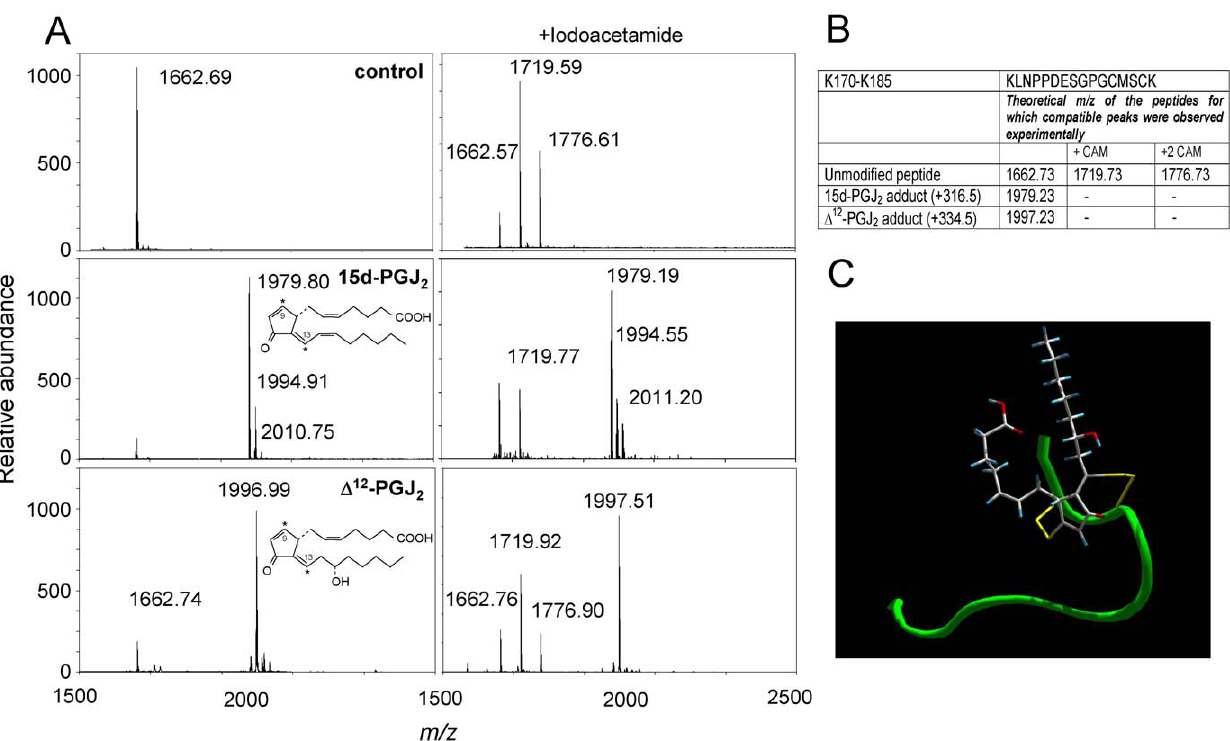
Figure 1. Modification of the K170-K185 peptide from the C-terminal region of H-Ras by cyPG. (A) The synthetic K170-K185 peptide was incubated with the indicated cyPG and the resulting adducts analyzed by MALDI-TOF MS. When indicated, incubation mixtures were treated with 50 mM iodoacetamide after addition of 10 mM DTT. Spectra presented are representative from at least three independent assays per experimental condition. Structures of the cyPG used are shown in insets. Electrophilic carbons are marked by asterisks. (B) Summary of the theoretical peptide adducts for which compatible peaks were observed experimentally. + CAM indicates that the peak is compatible with the formation of carbamidomethyl cysteine subsequent to iodoacetamide treatment. (C) Ribbon diagram for the theoretical backbone structure of the H-Ras K170- K185 peptide (in green) modified by addition of 15d-PGJ 2 to cysteines 181 and 184. The side-chains of the cysteine residues and the 15d-PGJ 2 ligand are displayed in yellow and a default atom-type color scheme,